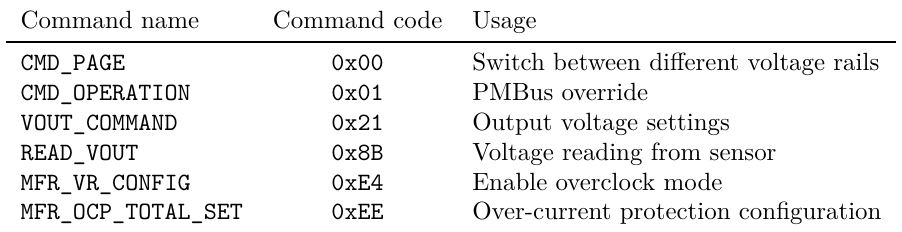
Table 1: Discovered PMBus commands on